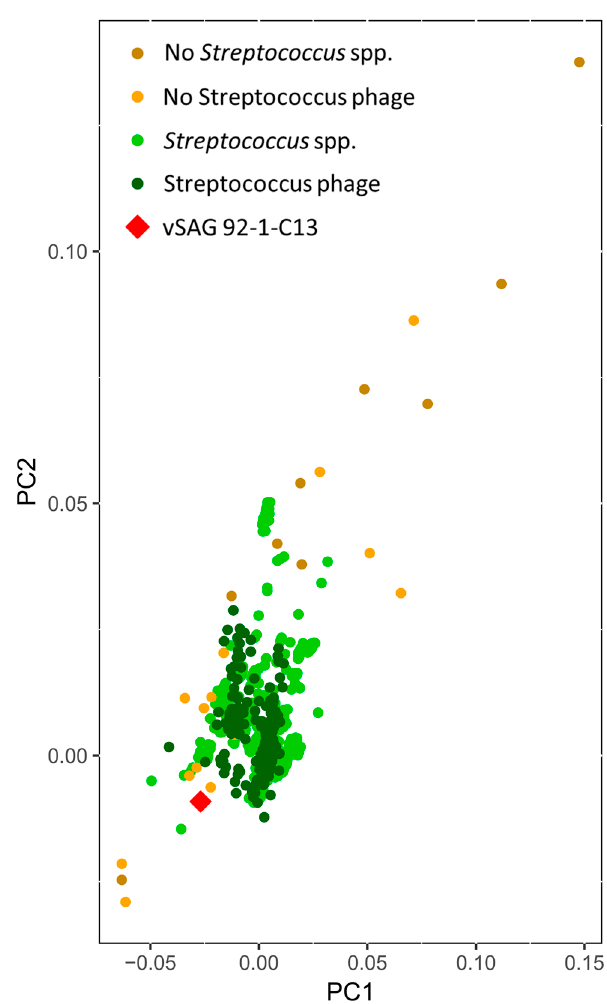
Figure 5. Principal component analysis of tetranucleotide frequencies. For the analysis, we compare 189 oral bacteriophages, 10,751 putative bacterial hosts, and vSAG 92-1-C13, in order to define the connection between vSAG 92-1-C13 and all populations present in the oral cavity.